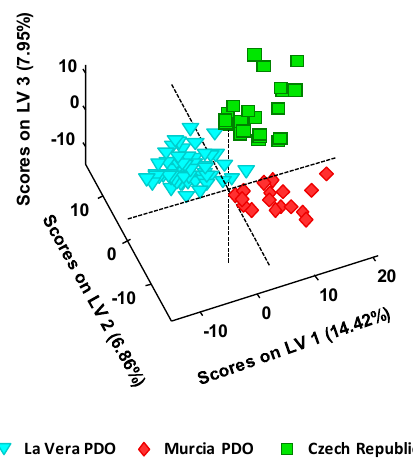
Figure 3. PLS-DA 3D score plot of LV1 vs. LV2 vs. LV3 when UHPLC-HRMS fingerprints were employed as chemical descriptors for the classification of the analyzed paprika samples according to their PDO and production region.